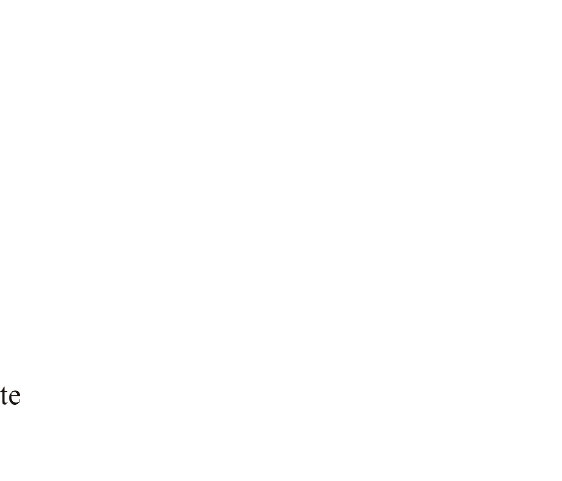
Figure 10. Equilibrium composition of the discussed rocks.